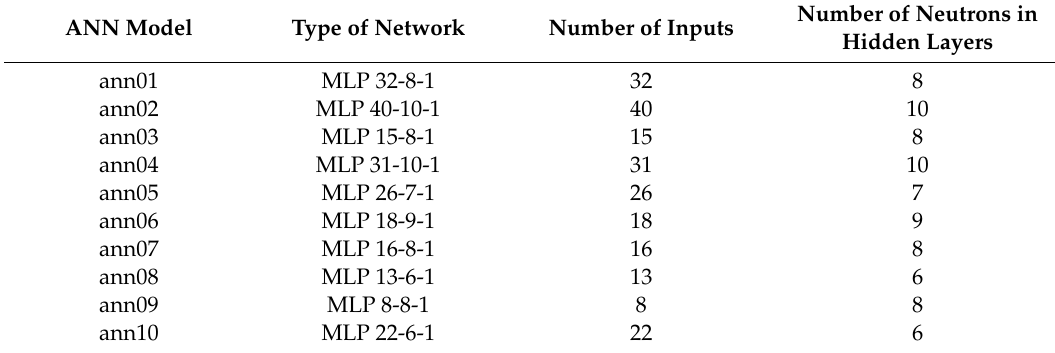
Table 1. Characteristics of neural models.